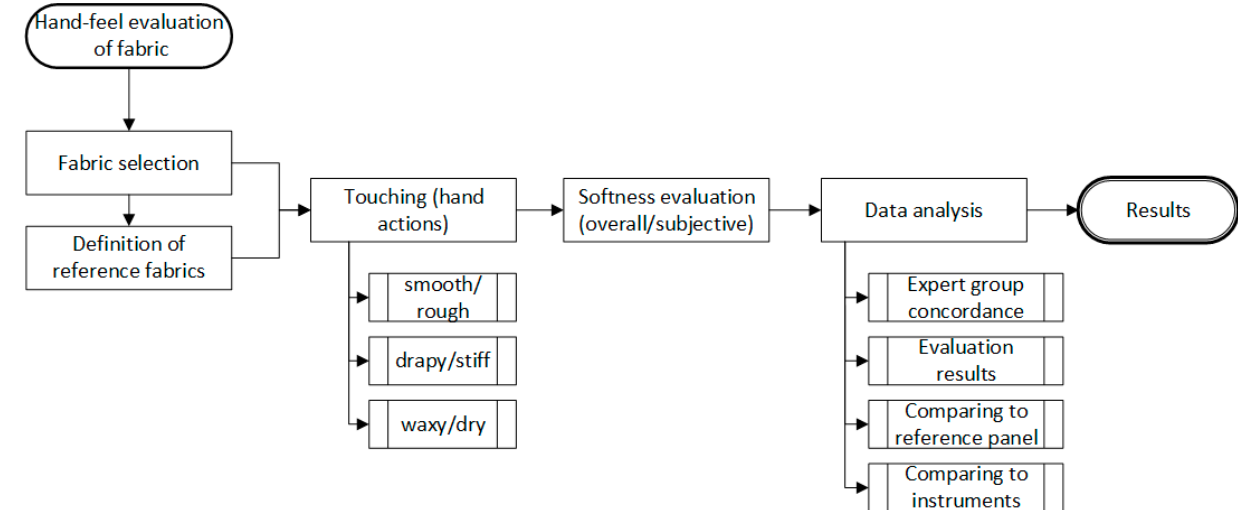
Figure 2. Design of evaluation process.